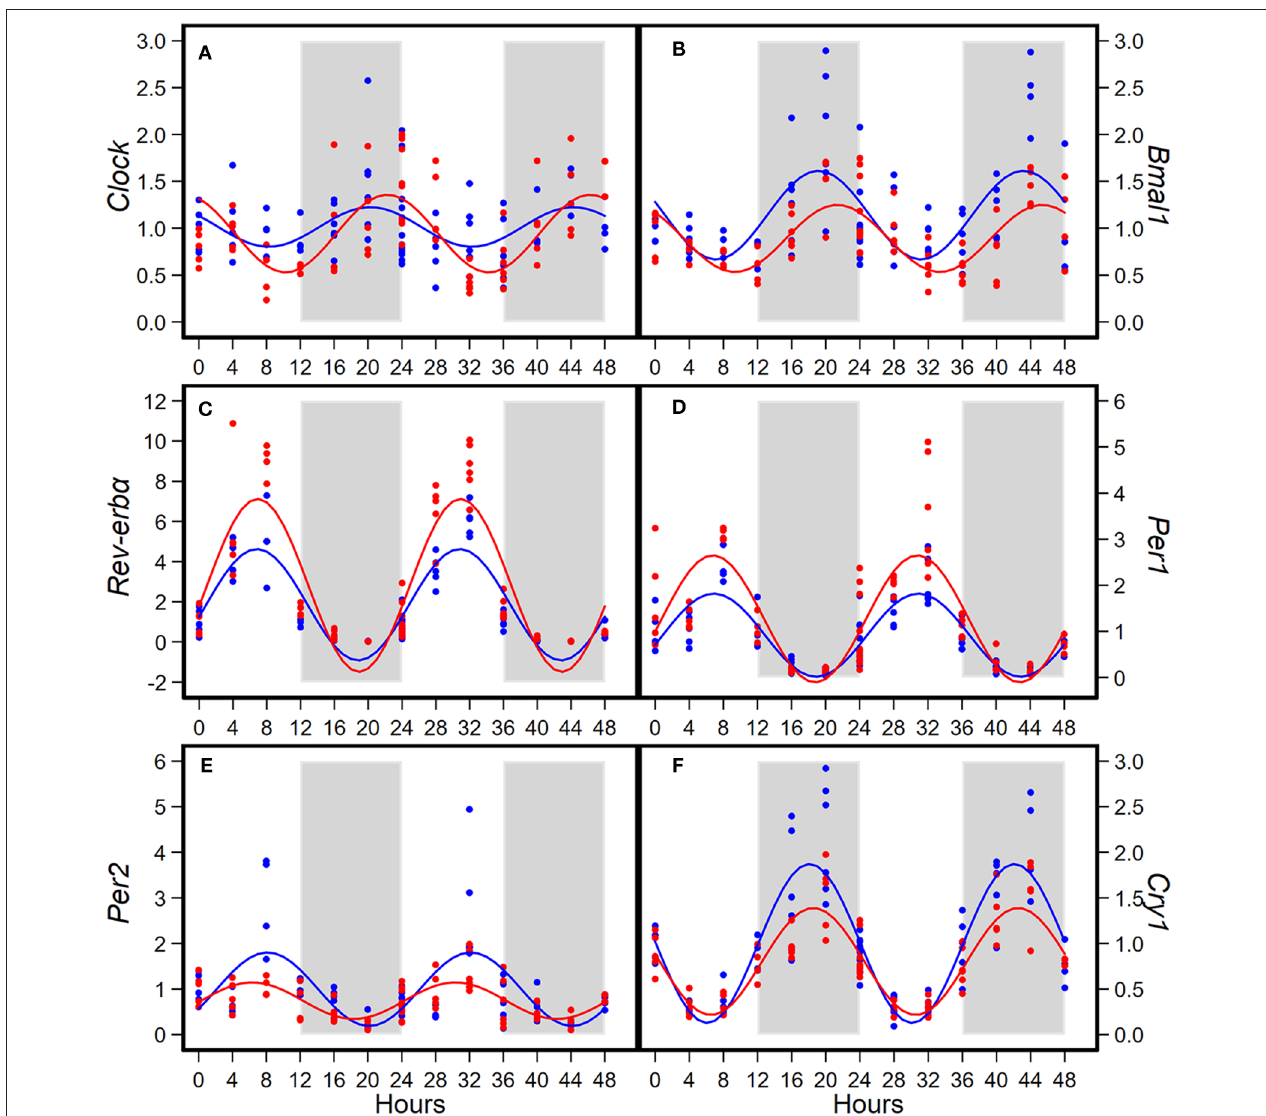
FIGURE 2 | Diurnal expressions of Clock (A) , Bmal1 (B) , Rev-erb α (C) , Per1 (D) , Per2 (E) , and Cry1 (F) in mammary glands from pubertal mice fed AIN93G or high-fat diet ( n = 5 per time point per group). Open background: light phase; gray background: dark phase; blue circles and line: AIN93G diet; red circles and line: high-fat diet. The rhythm curves were generated by using the Cosinor model y = mesor + amplitude x Cos [2 π /24 × (t—acrophase)].